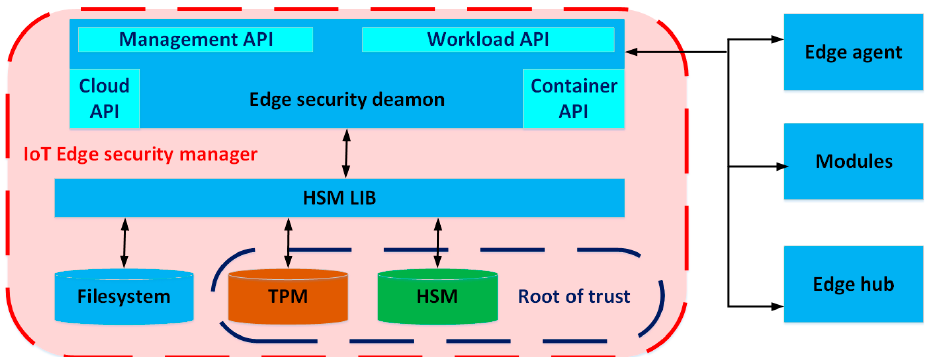
Figure 7. IoT edge security daemon structure and communication.